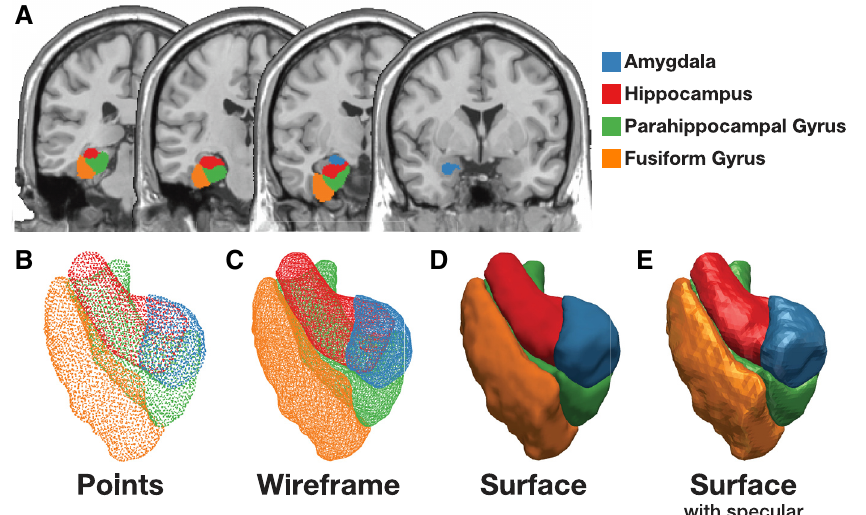
Figure 4. Images of the anatomical ROIs used in Procedure #2. ( a ) Coronal slices of the anatomical ROIs. Panels B-E depict different 3D rendering settings of the ROIs, ( b ) points along the surface of the ROIs, ( c ) wireframe, ( d ) surface, and ( e ) surface rendering with specular. Note that the structural image used in panel A is from a different source than the traced ROIs, and thus they do not perfectly align.